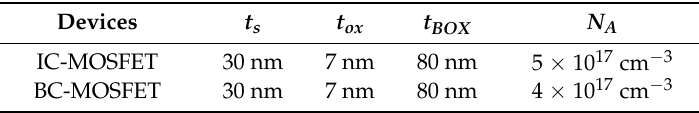
Figure 1. Schematic silicon-on-insulator (SOI) device structures used in experiments. ( a ) n-type inversion-channel (IC) metal-oxide-semiconductor field-effect transistors (MOSFET), ( b ) p-type buried-channel (BC) MOSFET. Table 1. Parameters of fabricated devices.